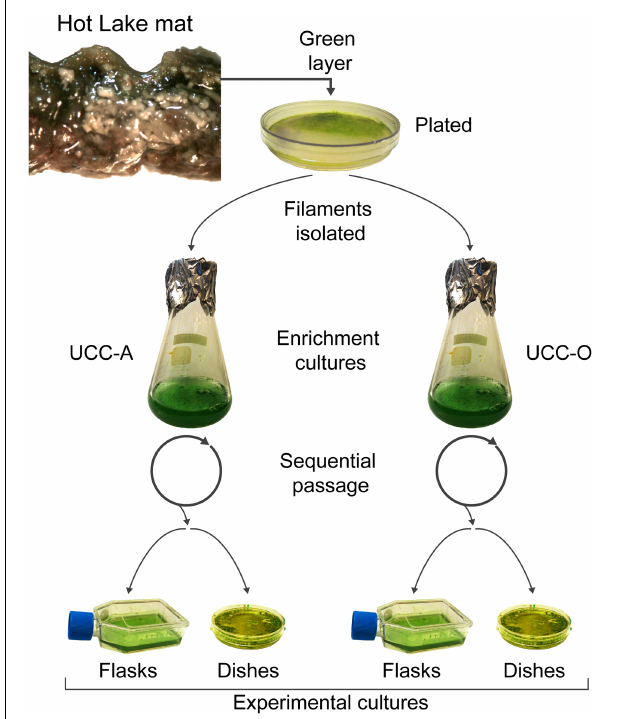
FIGURE 1 | Isolation and cultivation of the unicyanobacterial consortia. Biomass from a sample of the green layer of the Hot Lake mat was streaked onto plates. Two morphologically-distinct cyanobacterial filaments were isolated and inoculated into broth enrichment cultures. These enrichment cultures were sequentially passaged and served as inocula for experimental cultures. Experimental cultures were grown in tissue culture flasks for metabolomic, composition (dry weight, total protein, chlorophyll a , cell counts), and real-time PCR analyses. Glass-bottom dishes were used for microscopic analysis of the